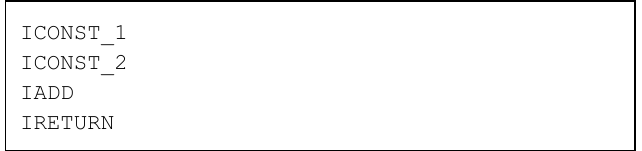
Fig. 1. JVM bytecode using mathematical operations.